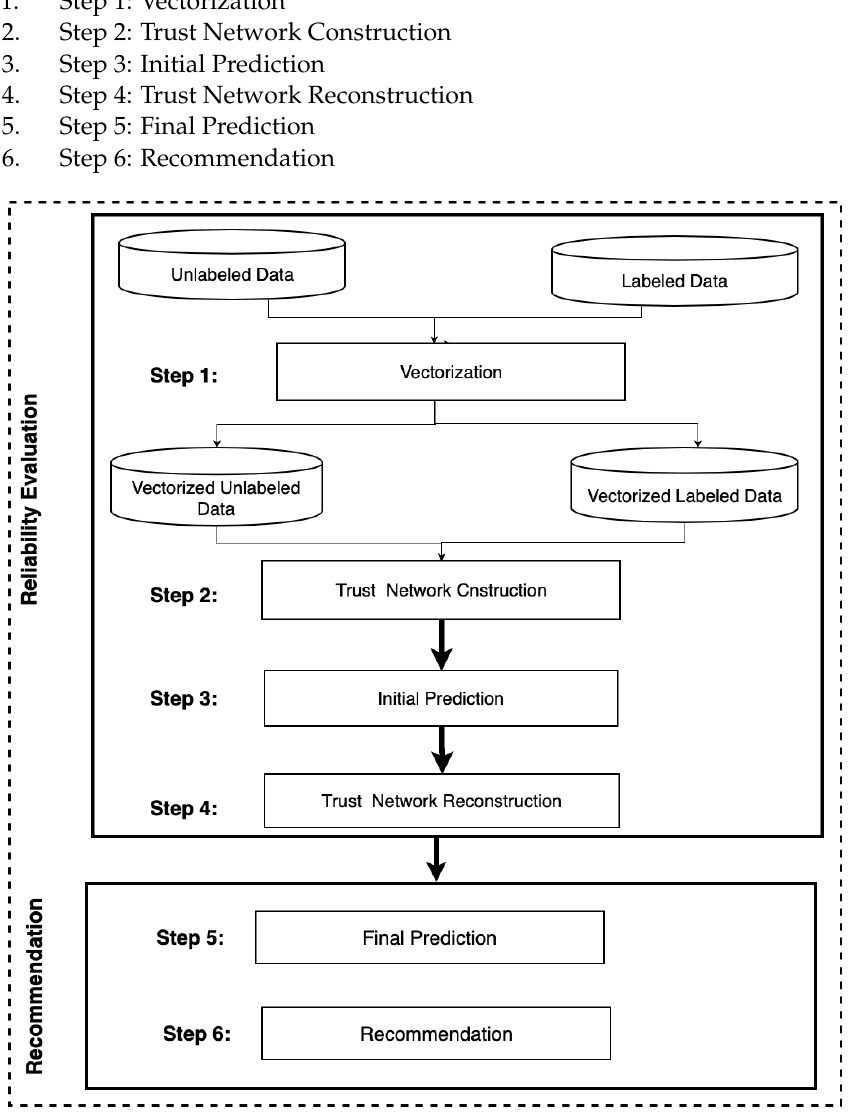
Figure 3. Overview of proposed